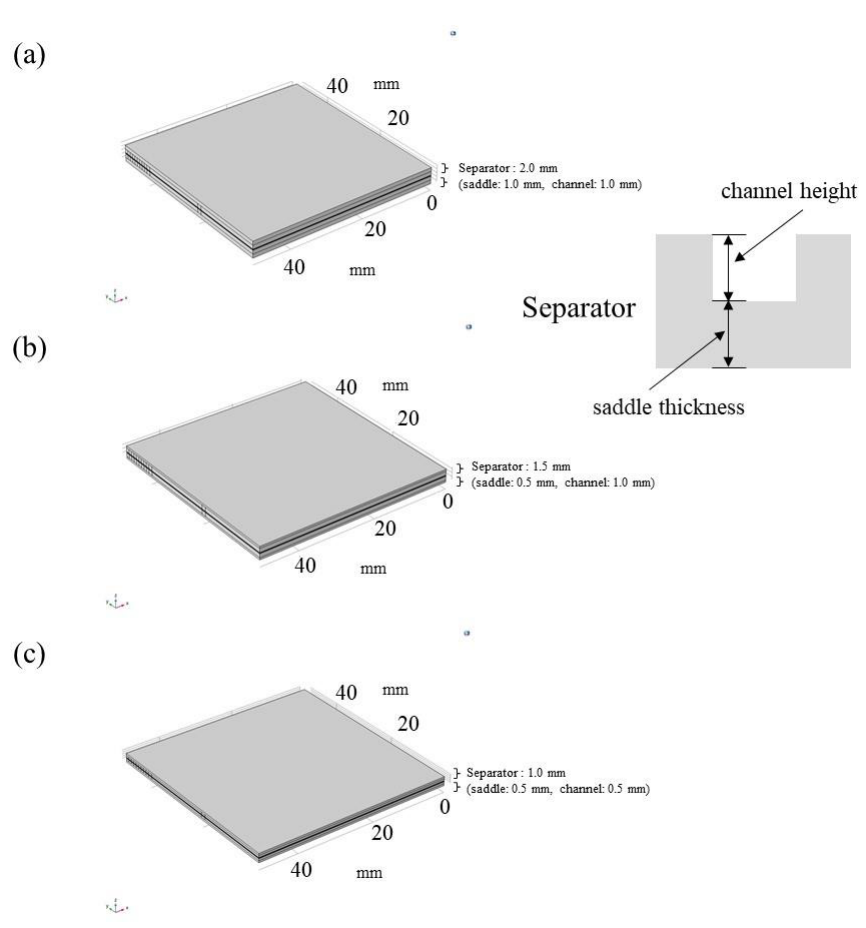
Figure 1. 3D model of single PEFC ( a ) s.t. of 2.0 mm = sd.t.: 1.0 mm + c.h.: 1.0 mm, ( b ) s.t. of 1.5 mm = sd.t.: 0.5 mm + c.h.: 1.0 mm, ( c ) s.t. of 1.0 mm = sd.t.: 0.5 mm + c.h.: 0.5 mm. Table 1. Geometrical parameters of components in single cell of PEFC applied for 3D model in the numerical simulation in this study [14,29 – 33].